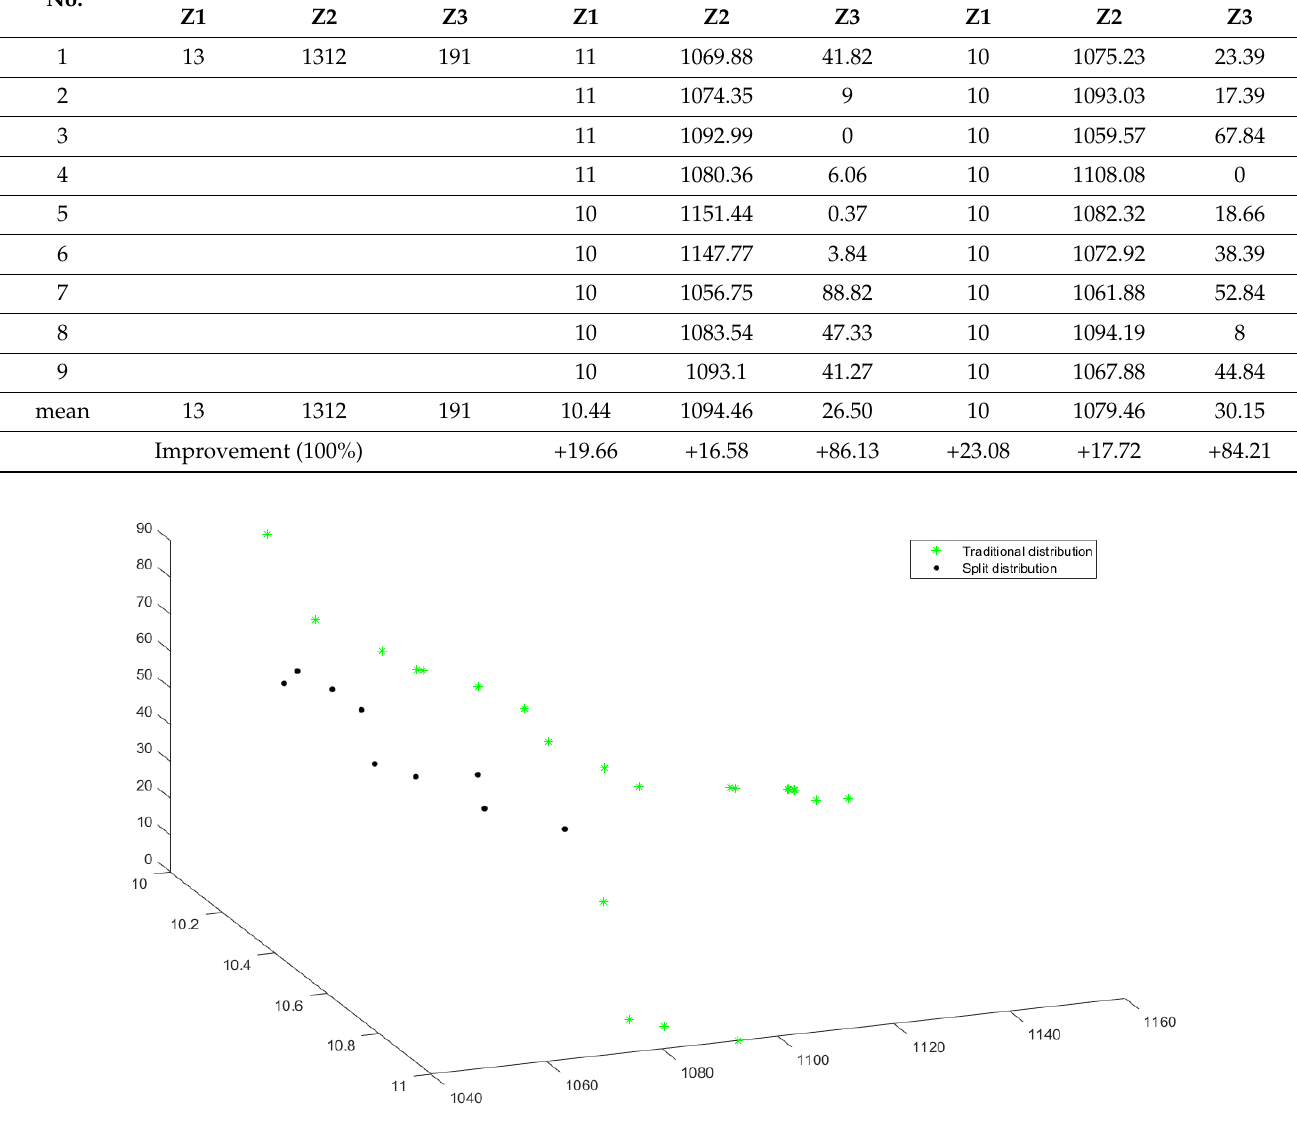
Figure 12. Comparison between the Pareto frontier solutions for the production task. Table 9. The best result of case study.